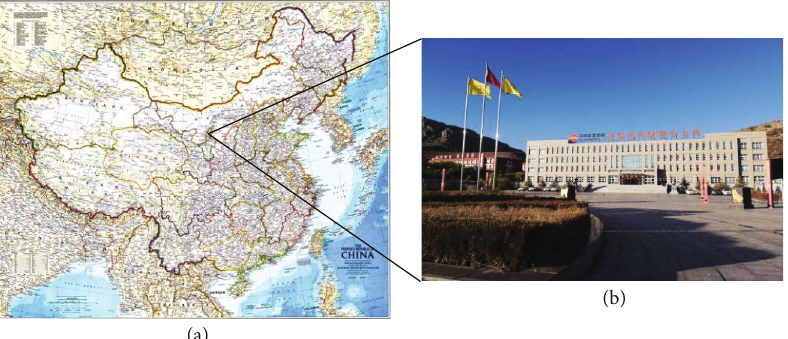
Figure 1: (a) Mine Location, Ningxia Province, China. (b) Panorama of the coal